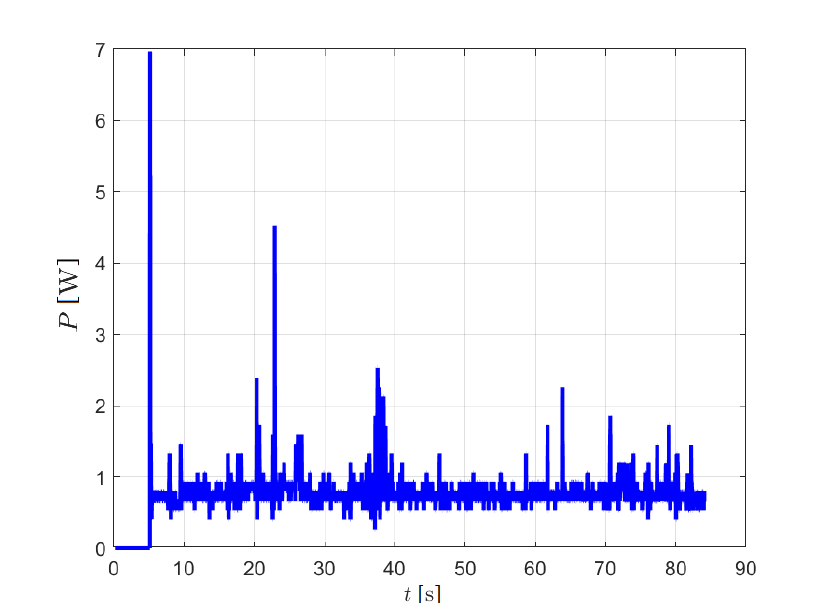
Figure 42. Power P during Map 3 run for the RRT algorithm of the